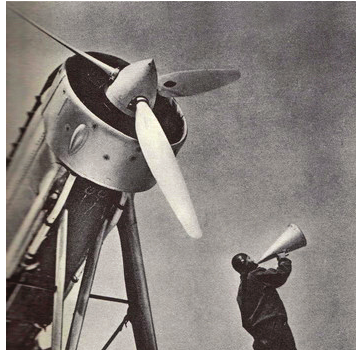
Fig. 1. Le Corbusier, Aircraft , (1935). Figure 116: “ Another is our destiny”